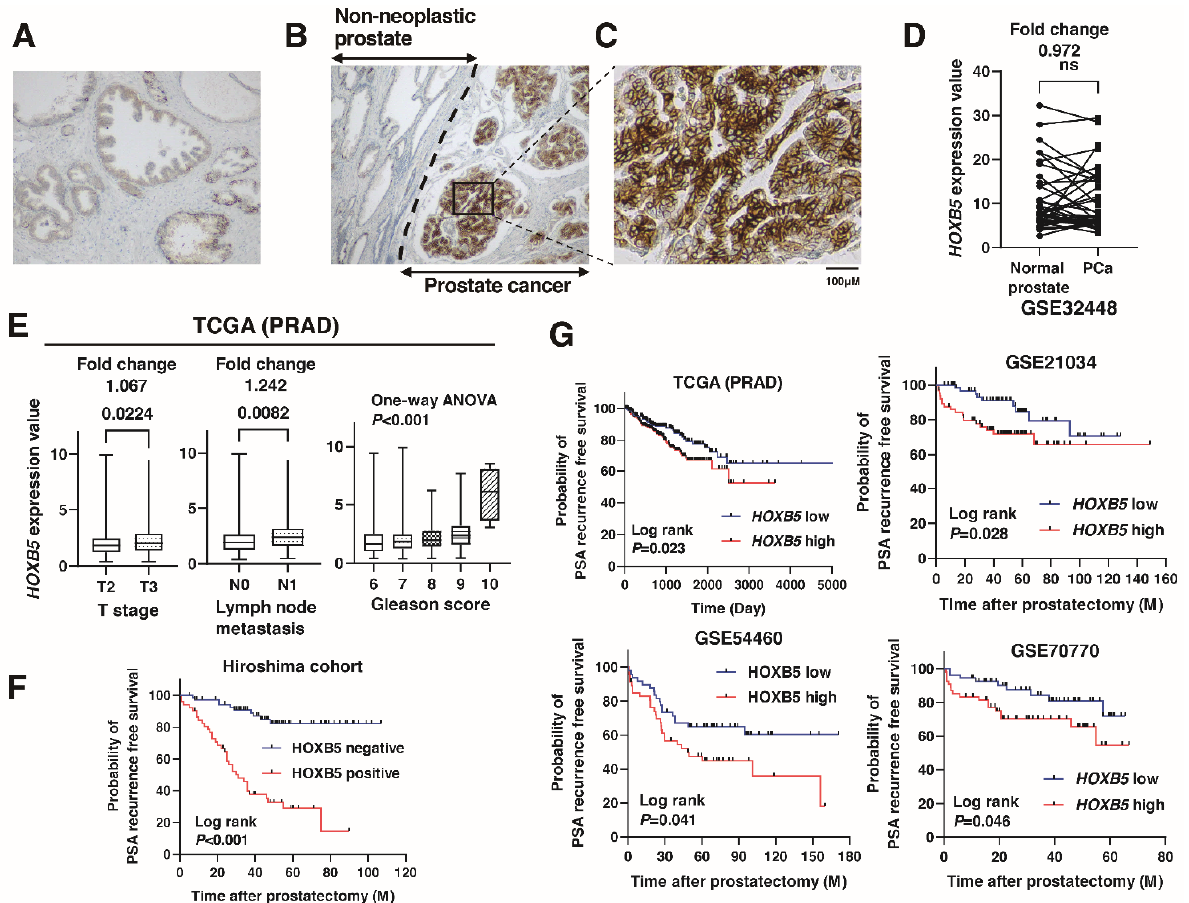
Figure 1. The expression of HOXB5 in localized prostate cancer (PCa). ( A ) Immunohistochemical staining in non-neoplastic prostate. Original magnification: 100 × . ( B ) Immunohistochemical staining of HOXB5 in PCa. Original magnification: 100 × . ( C ) Immunohistochemical staining of HOXB5 in PCa. Original magnification: 400 × . Scale bar = 100 µ m. ( D ) Scatter plot of HOXB5 expression in normal prostate and PCa from GSE32448. ns: not significant. Fold changes are indicated. ( E ) Comparisons of HOXB5 mRNA expression levels between T stages, lymph node metastasis, and Gleason scores are displayed as a box plot from TCGA (PRAD) datasets. Fold changes are indicated. ( F ) Kaplan–Meier plot of PSA recurrence-free survival of PCa patients with HOXB5 expression after prostatectomy from the Hiroshima cohort. ( G ) Kaplan–Meier plot of PSA recurrence-free survival of PCa patients with HOXB5 expression after prostatectomy from TCGA (PRAD), GSE21034, GSE54460 and GSE70770. Table 1. Relationship between HOXB5 expression and clinicopathologic characteristics in the 128 patients with prostate cancer.